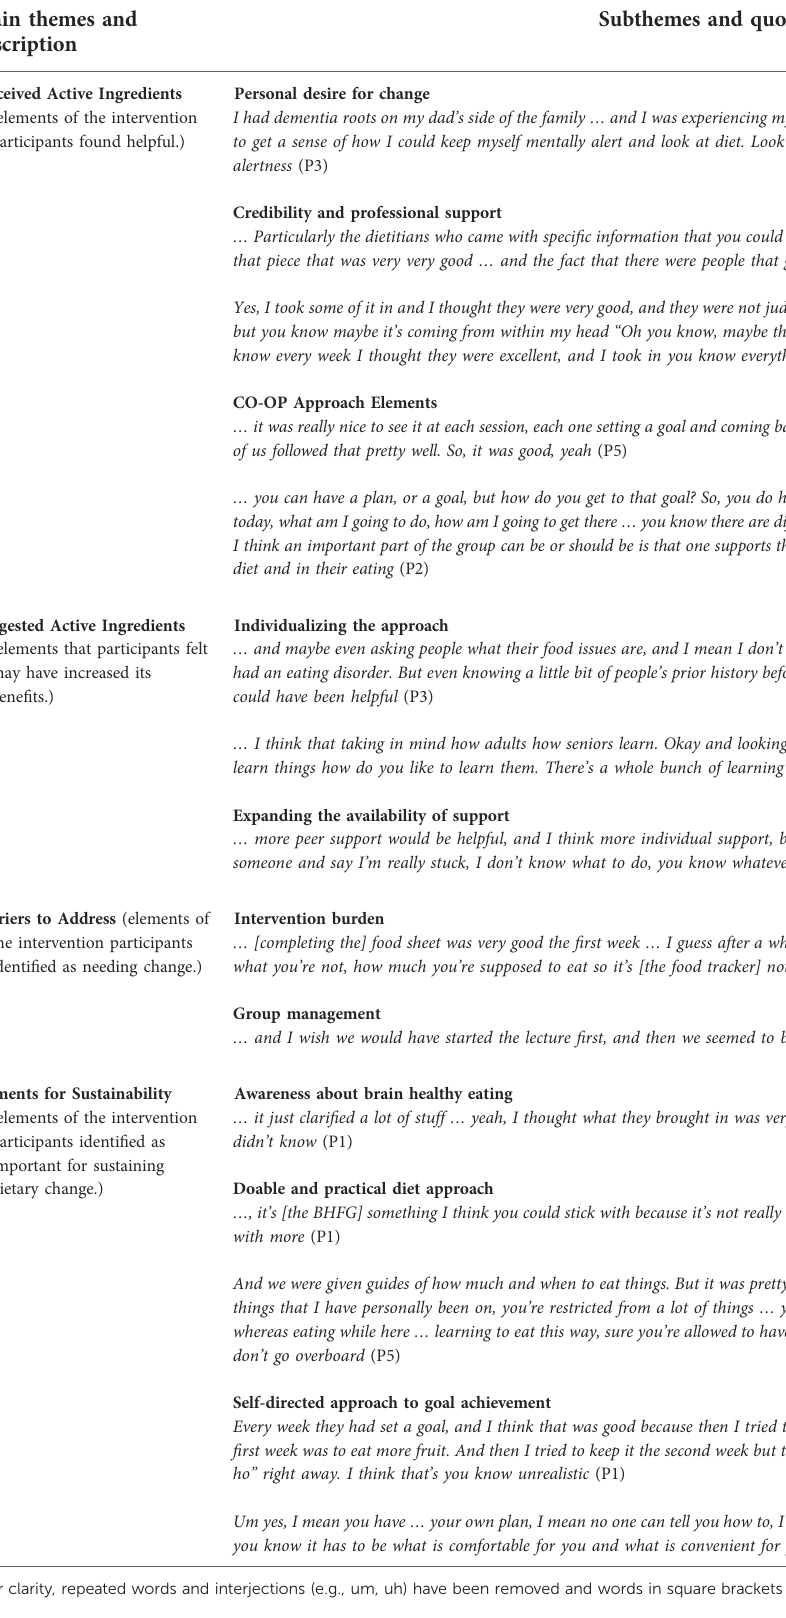
TABLE 2 Themes, subthemes and supporting quotes*.